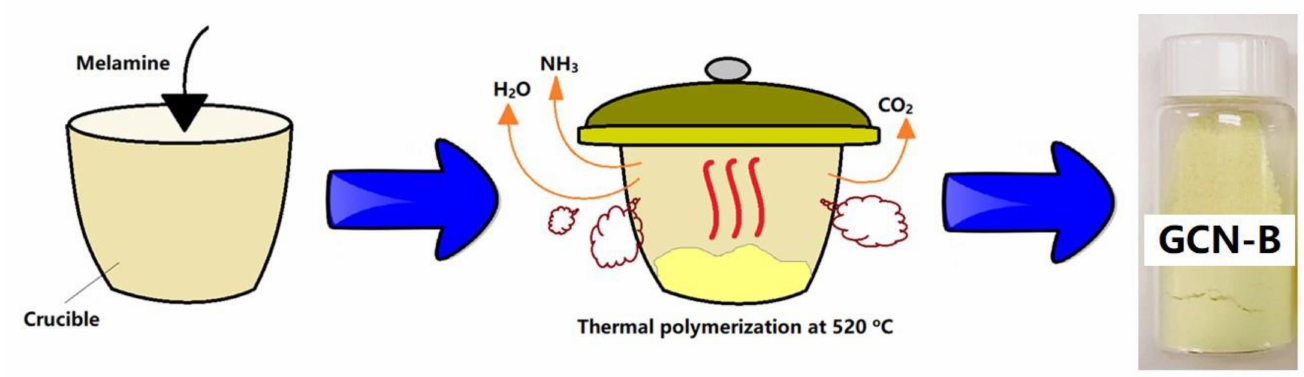
Figure 1. Schematic flow of the GCN synthesis process.